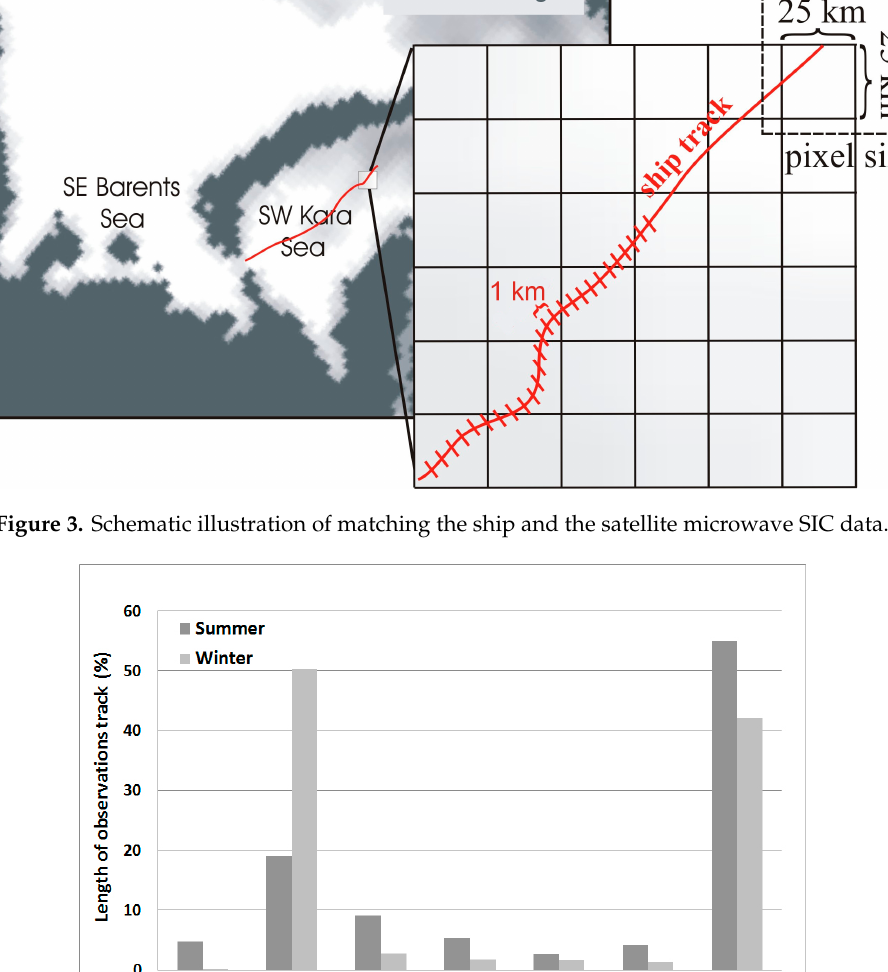
Figure 4. Distribution of observed visibility in % of ship track length. Visibility was recalculated from nautical miles (units of observations) to kilometers.